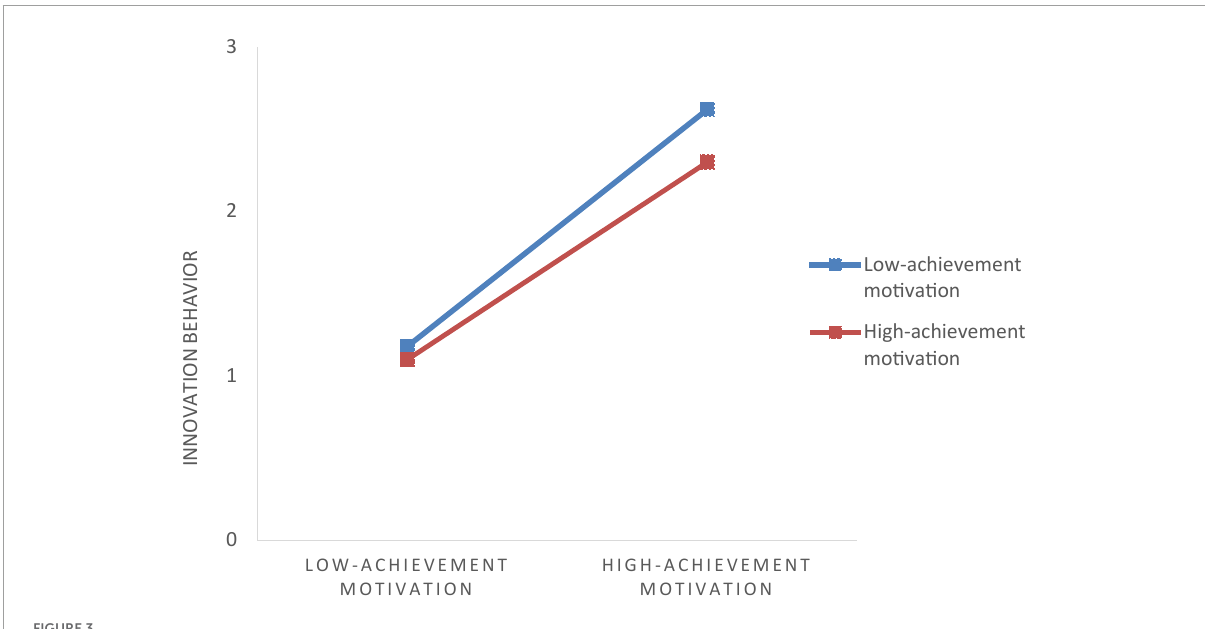
FIGURE3 Moderating effect of organizational innovation climate between achievement and innovation behavior.